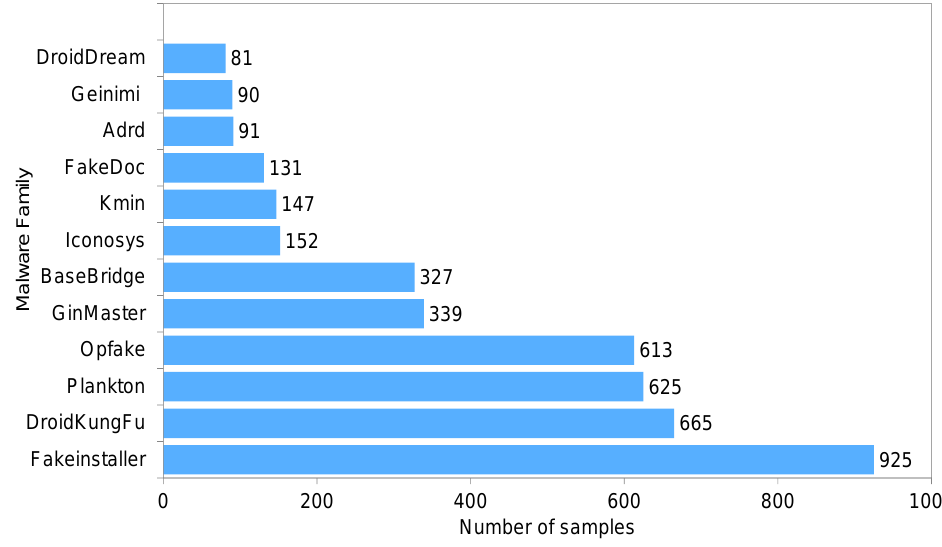
Figure 5. Variants of the Malware family in the database.